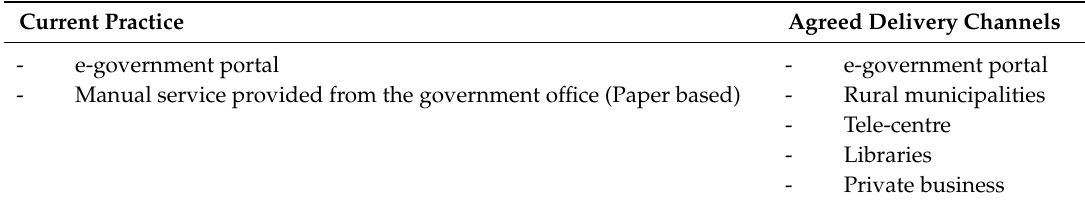
Table 5. Delivery channels for e-government